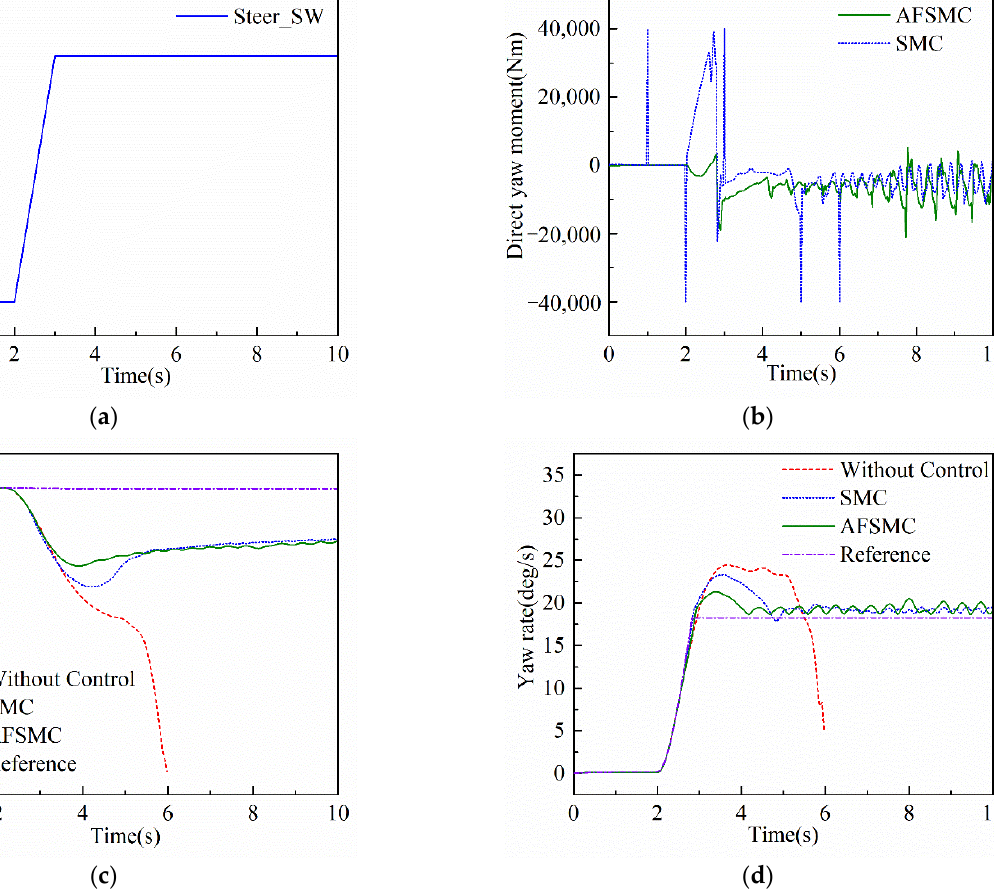
Figure 7. The simulation results of the step response test. ( a ) Steering wheel angle; ( b ) direct yaw moment; ( c ) sideslip angle; ( d ) yaw rate. Table 3. The peak valve of the sideslip angle and yaw rate under different simulation tests.